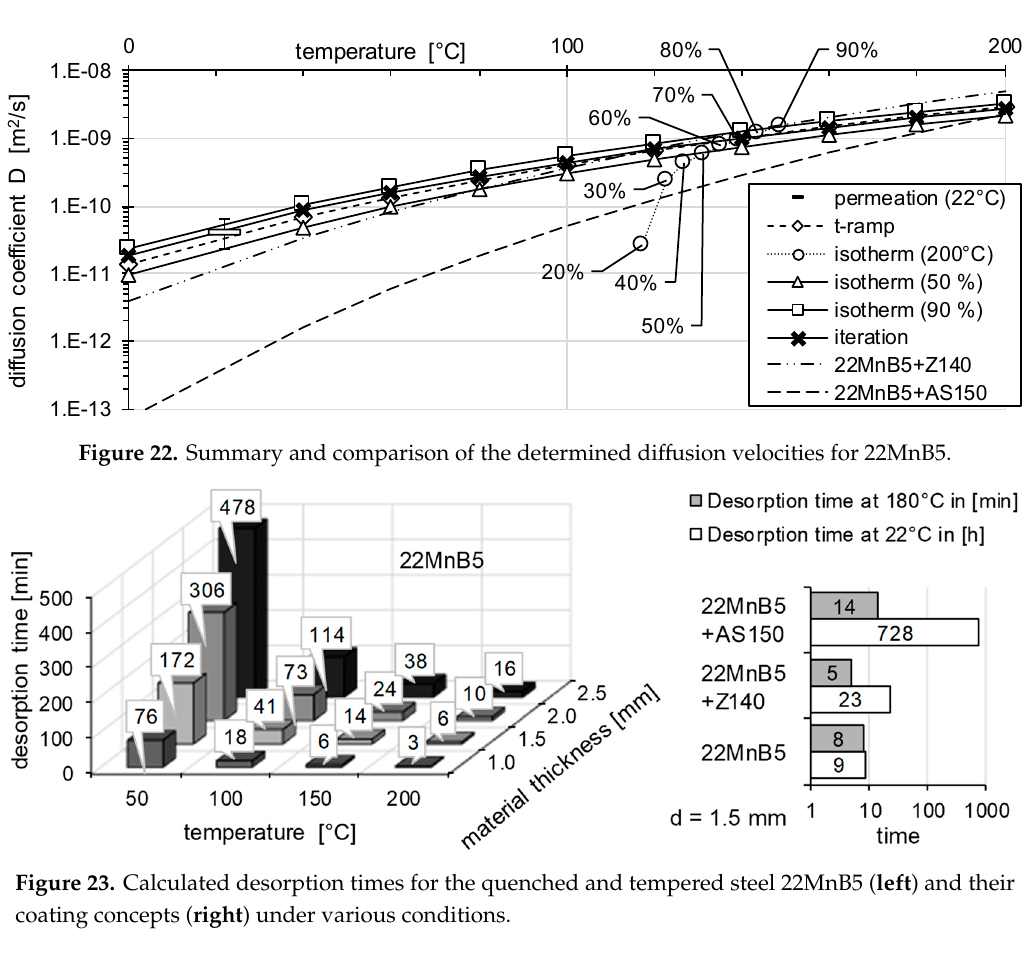
Figure 22. Summary and comparison of the determined diffusion velocities for 22MnB5.